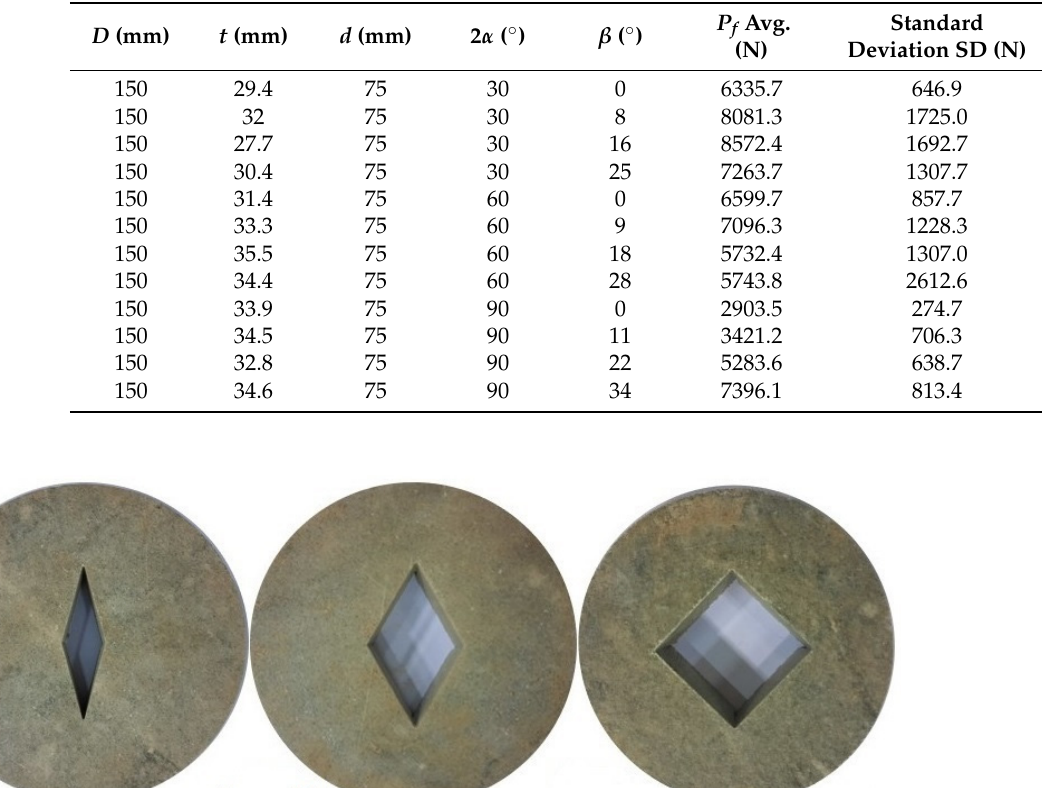
Table 1. Specimen dimensions, loading conditions, and fracture loads for the rock SVNBD samples tested in the present study.